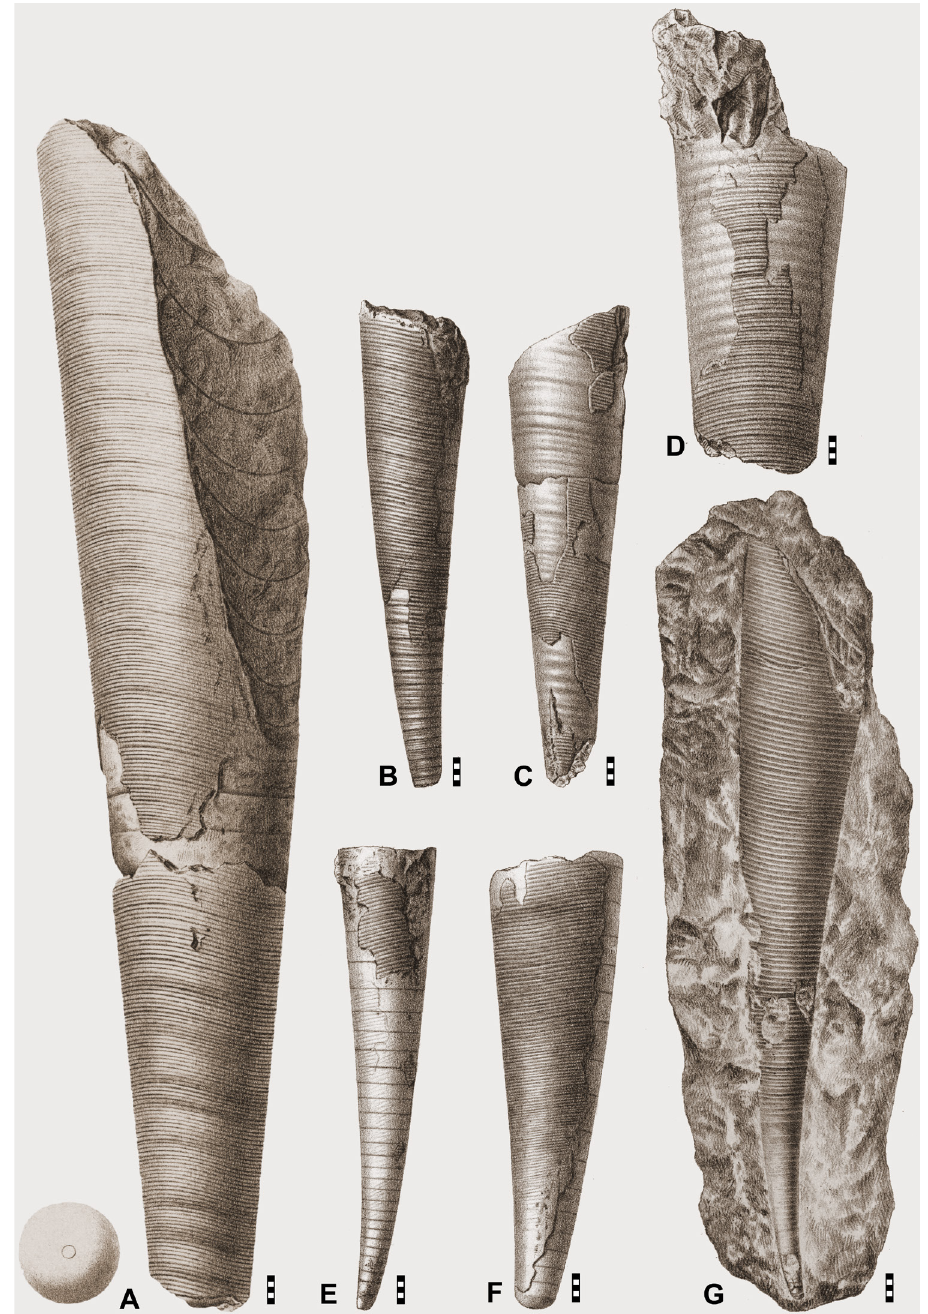
Fig. 9. Rhynchorthoceras angelini (Boll, 1857); reproductions of illustrations by Remelé (1890). A . Specimen MB.C.11724 from Heegermühle (Brandenburg), illustrated by Remelé (1890: pl. 3 fig. 5). B . Specimen MB.C. 11725.1 from Heegermühle (Brandenburg), illustrated by Remelé (1890: pl. 5 fig. 3). C . Specimen from Heegermühle (Brandenburg), illustrated by Remelé (1890: pl. 5 fig. 4). D . Specimen MB.C.11732.2 from Heegermühle (Brandenburg), illustrated by Remelé (1890: pl. 5 fig. 5). E . Specimen MB.C.11726.1 from Heegermühle (Brandenburg), illustrated by Remelé (1890: pl. 5 fig. 6). F . Specimen MB.C.11716 from Joachimsthal (Brandenburg), illustrated by Remelé (1890: pl. 5 fig. 7). G . Specimen MB.C.22577 from Heegermühle, illustrated by Remelé (1890: pl. 6 fig. 6). Scale bar units = 1